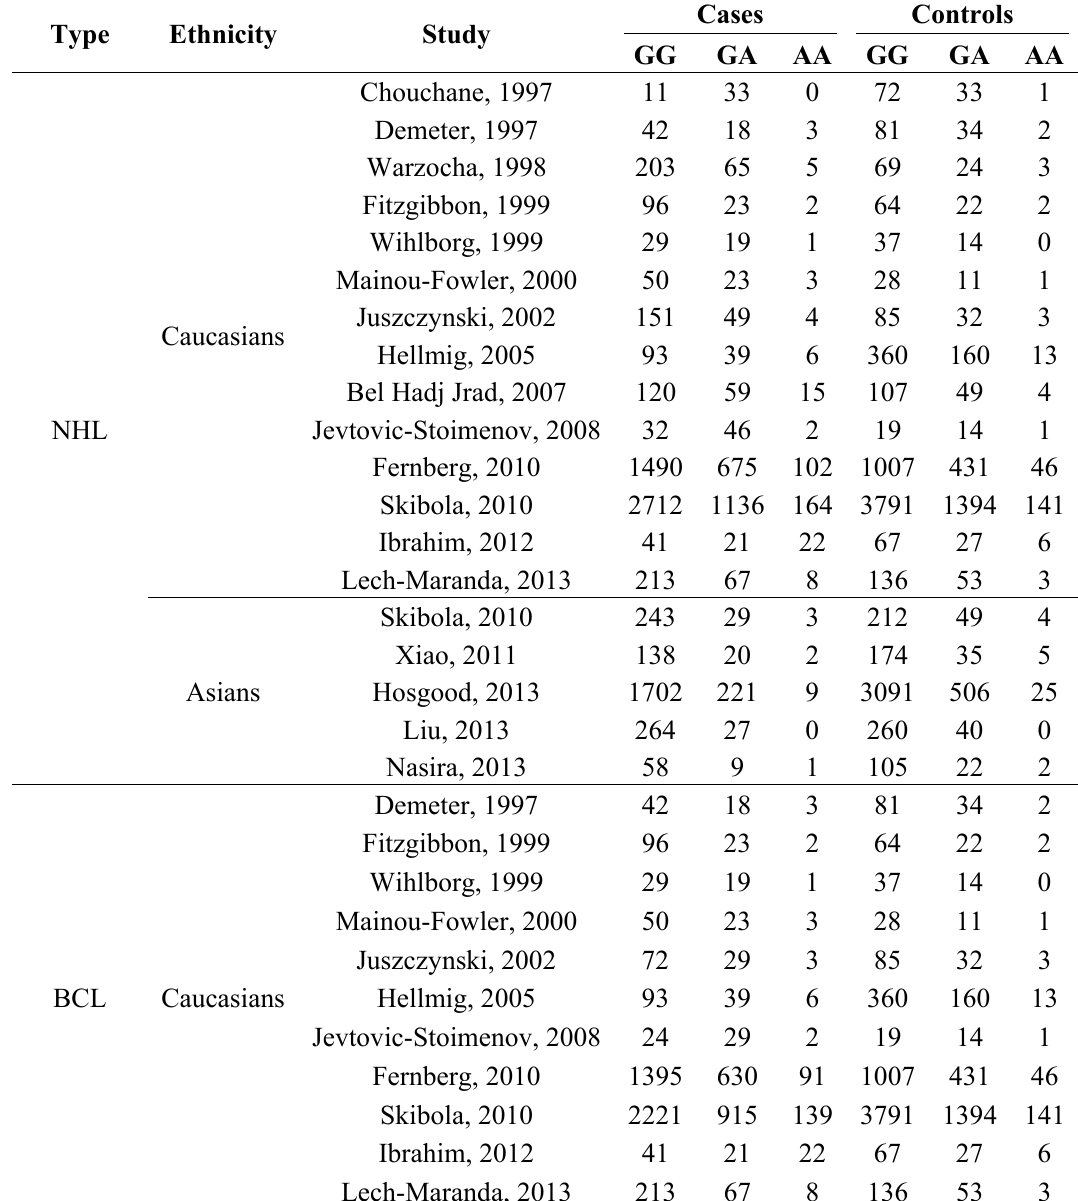
Table 3. Summary of primary data from eligible studies in this